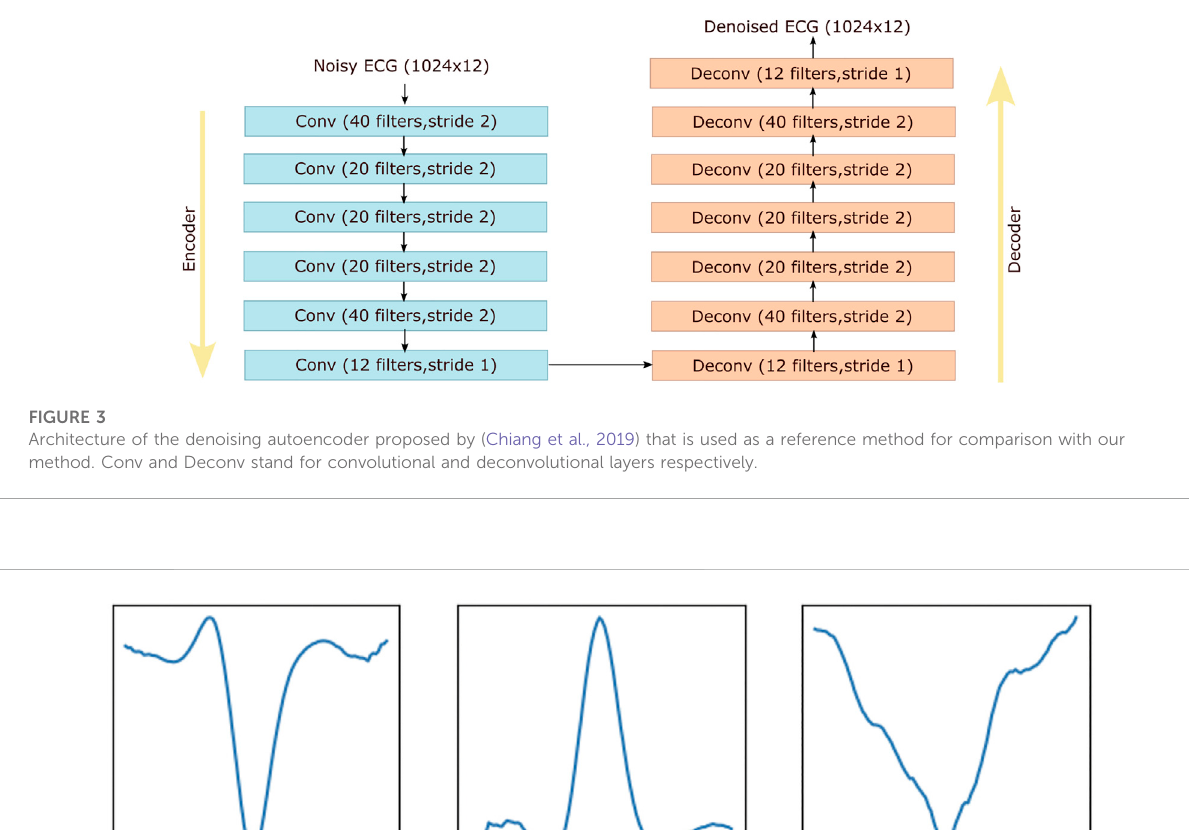
FIGURE 4 Example of fi lter kernels that are learned by the deep unfolding convolutional sparse coding network. These kernels are convoluted with the row-sparse matrix Z to yield the denoised ECG signals as output.